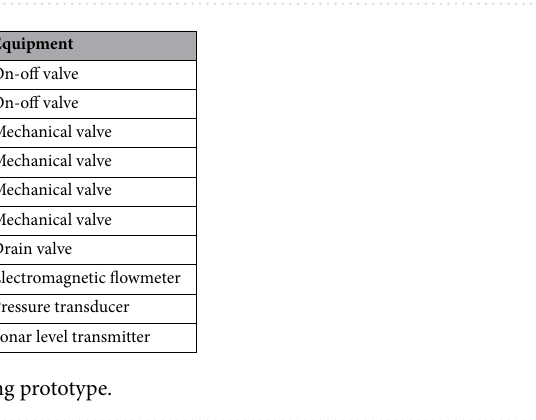
Figure 1. Water pumping stand prototype located at LEEQE. ( a ) Photography and ( b ) Diagram—created using PowerPoint software version Microsoft 365.